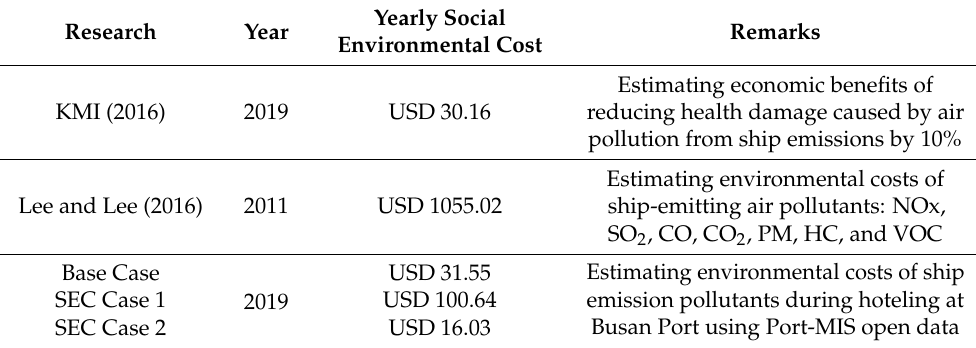
Table 14. Comparative analysis with existing research results estimating the social costs of air pollution emitted from hoteling ships at Busan